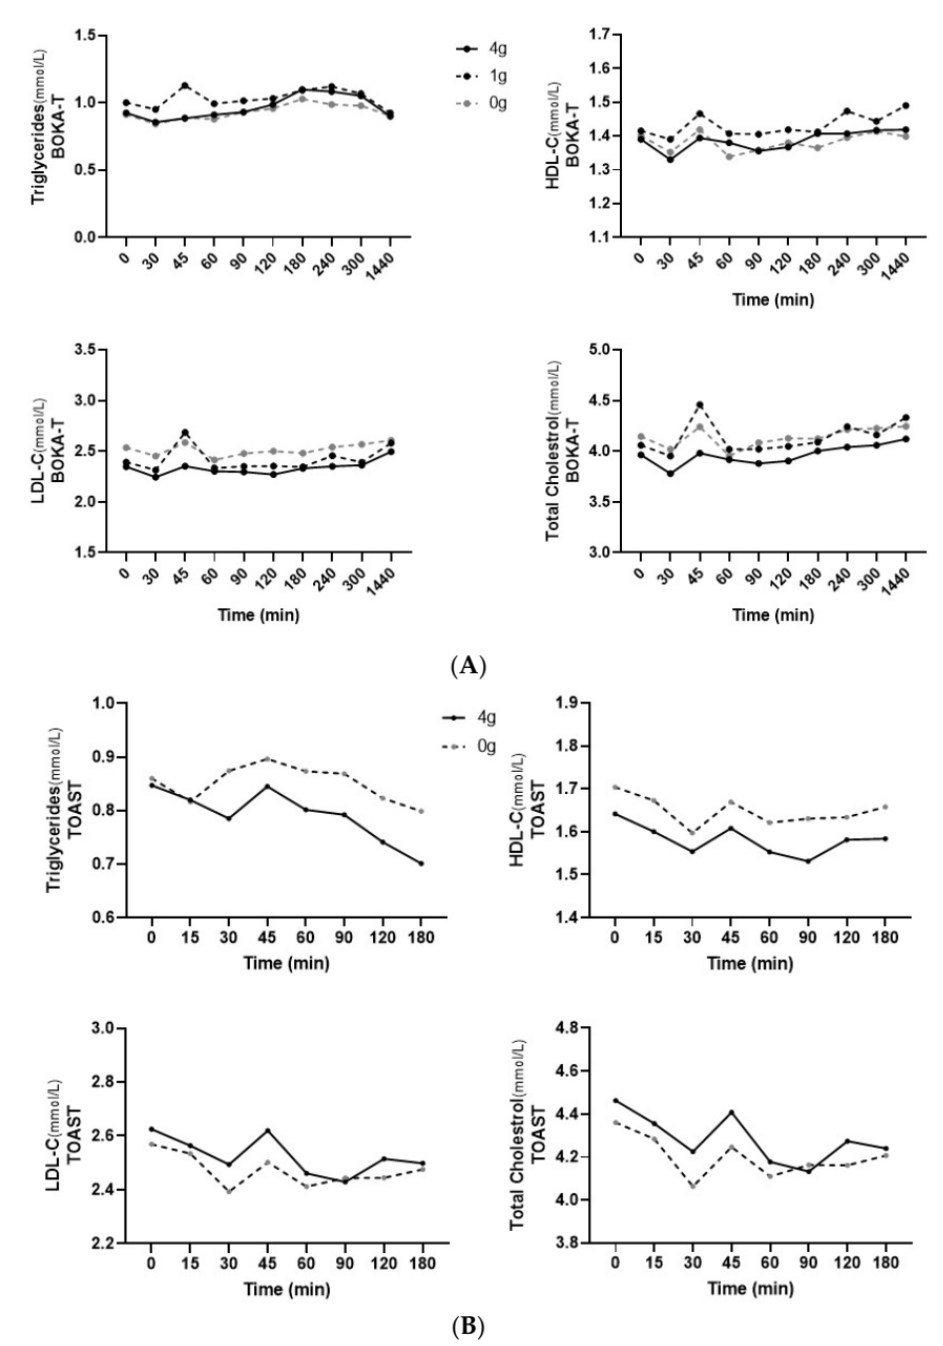
Figure 4. ( A ) Mean ± SEM plasma concentrations of plasma lipids for BOKA-T throughout the postprandial period. ( B ) Mean ± SEM plasma concentrations of plasma lipids for TOAST throughout the postprandial period; 0 g (only hot water), 1 g (1 g kawakawa/250 mL hot water) and 4 g (4 g kawakawa/250 mL hot water). Differences between the treatment group over the postprandial were determined using repeated-measures